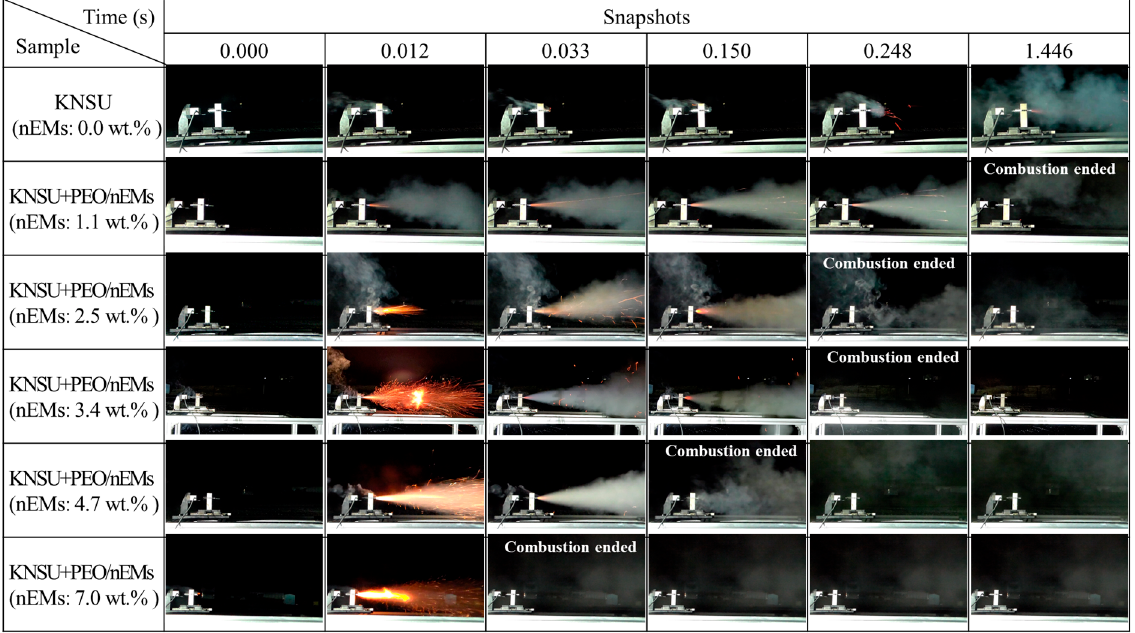
Figure 9. A series of still images of propulsion tests for small rocket motors charged with KNSU-based disks inserted with different amounts of PEO/nEM composite-based 3D-printed disks.